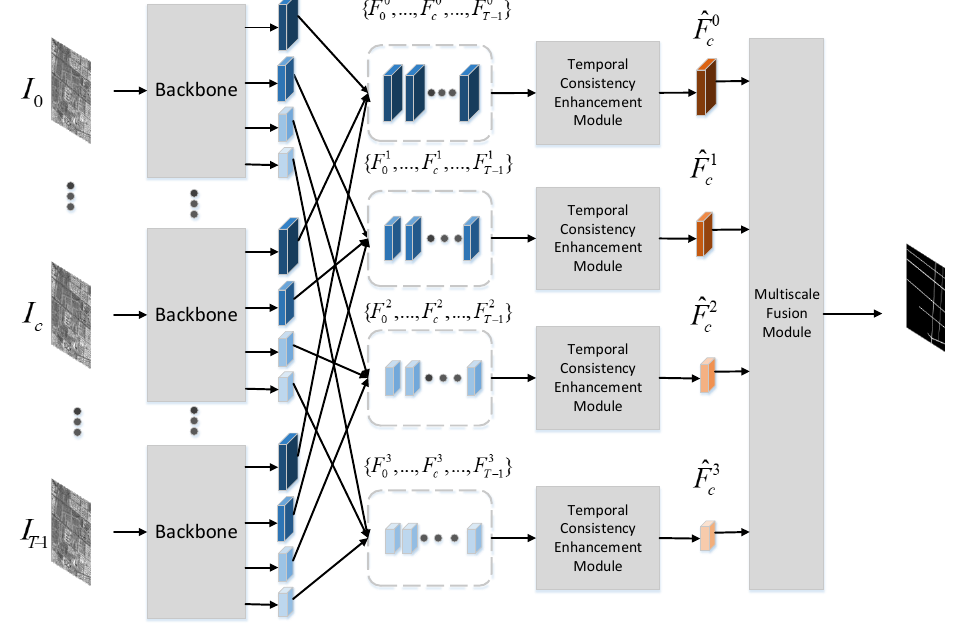
Figure 1. The overview of Multiscale and Multitemporal Road Detection Framework.